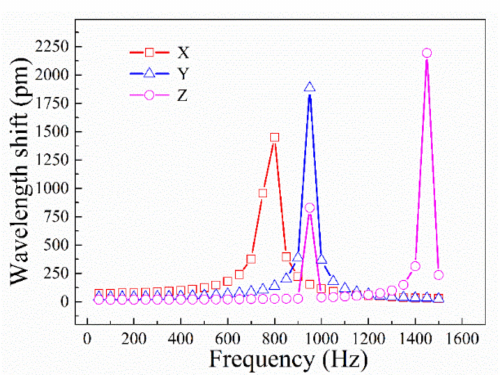
Figure 15. Sensor amplitude frequency curves along the x-, y-, and z-directions.